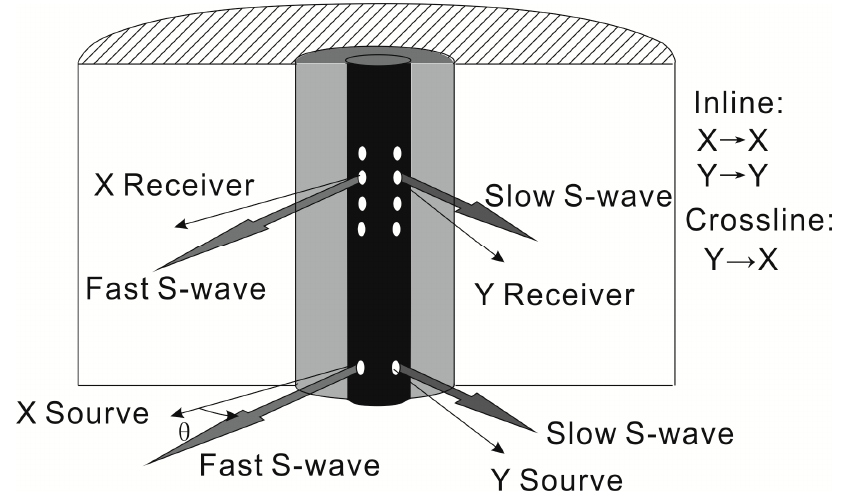
Figure 5. Schematic diagram for cross-dipole array acoustic logging in the anisotropic formation.